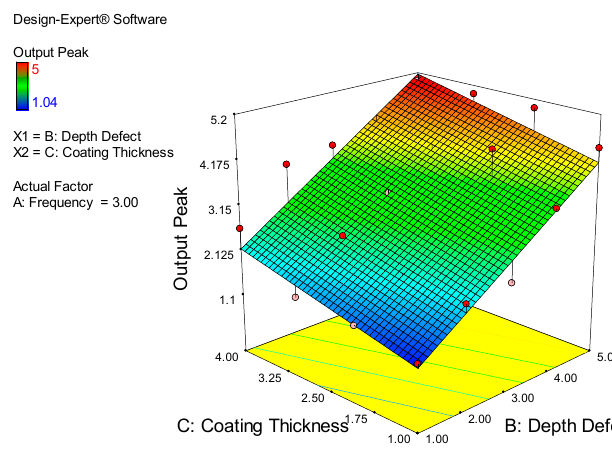
Figure 19. Relations between Depth of Defect, Coating Thickness and Output Peak.